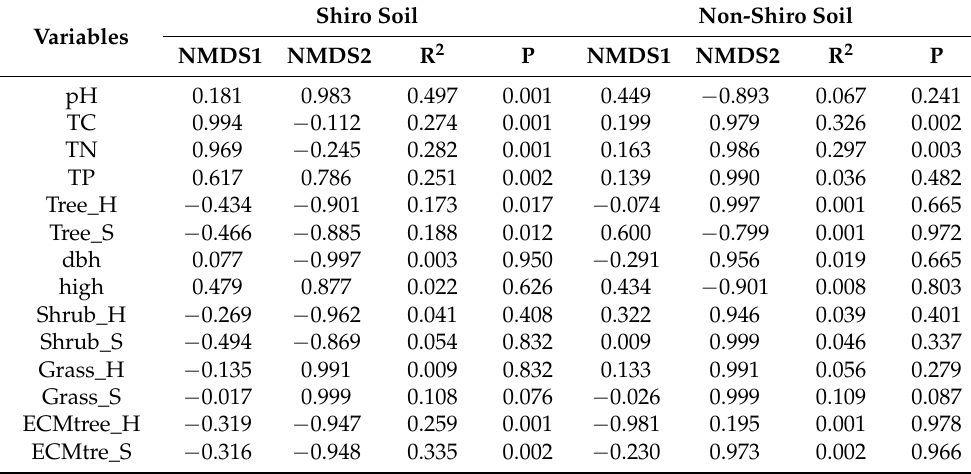
Table 3. Relationship of soil and plant variables with soil fungal community structure.